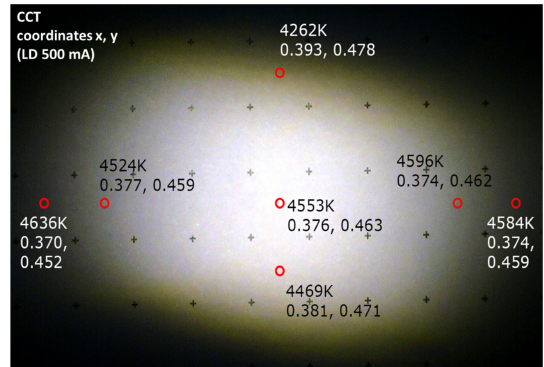
Figure 17. Target spot of the reflective LARP setup REFL1 (tilted reflector) at a distance of 330 mm from the light source.